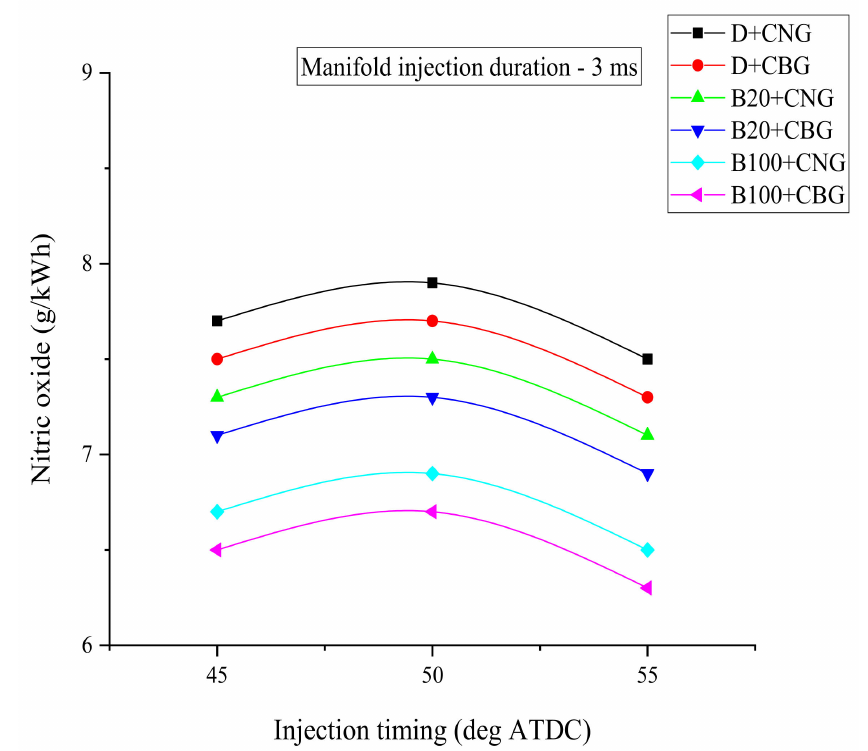
Figure 5. Variation of NOx emissions with IT.